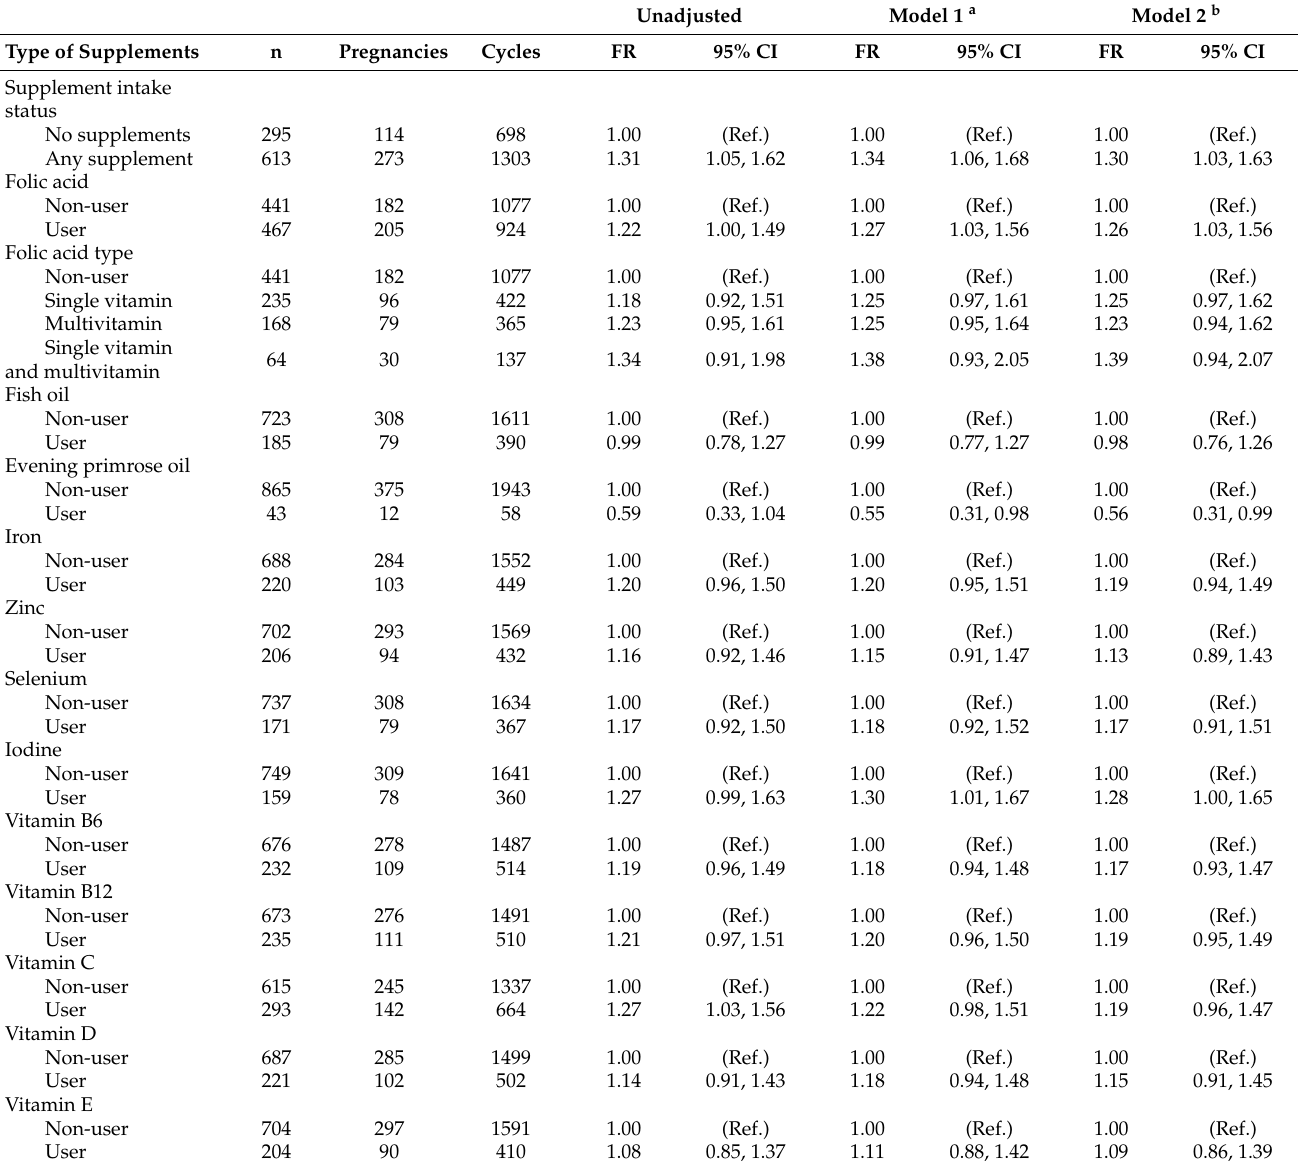
Table 2. Associations between supplement intake status and fecundability in women from the S-PRESTO study, 2015–2018 ( n =